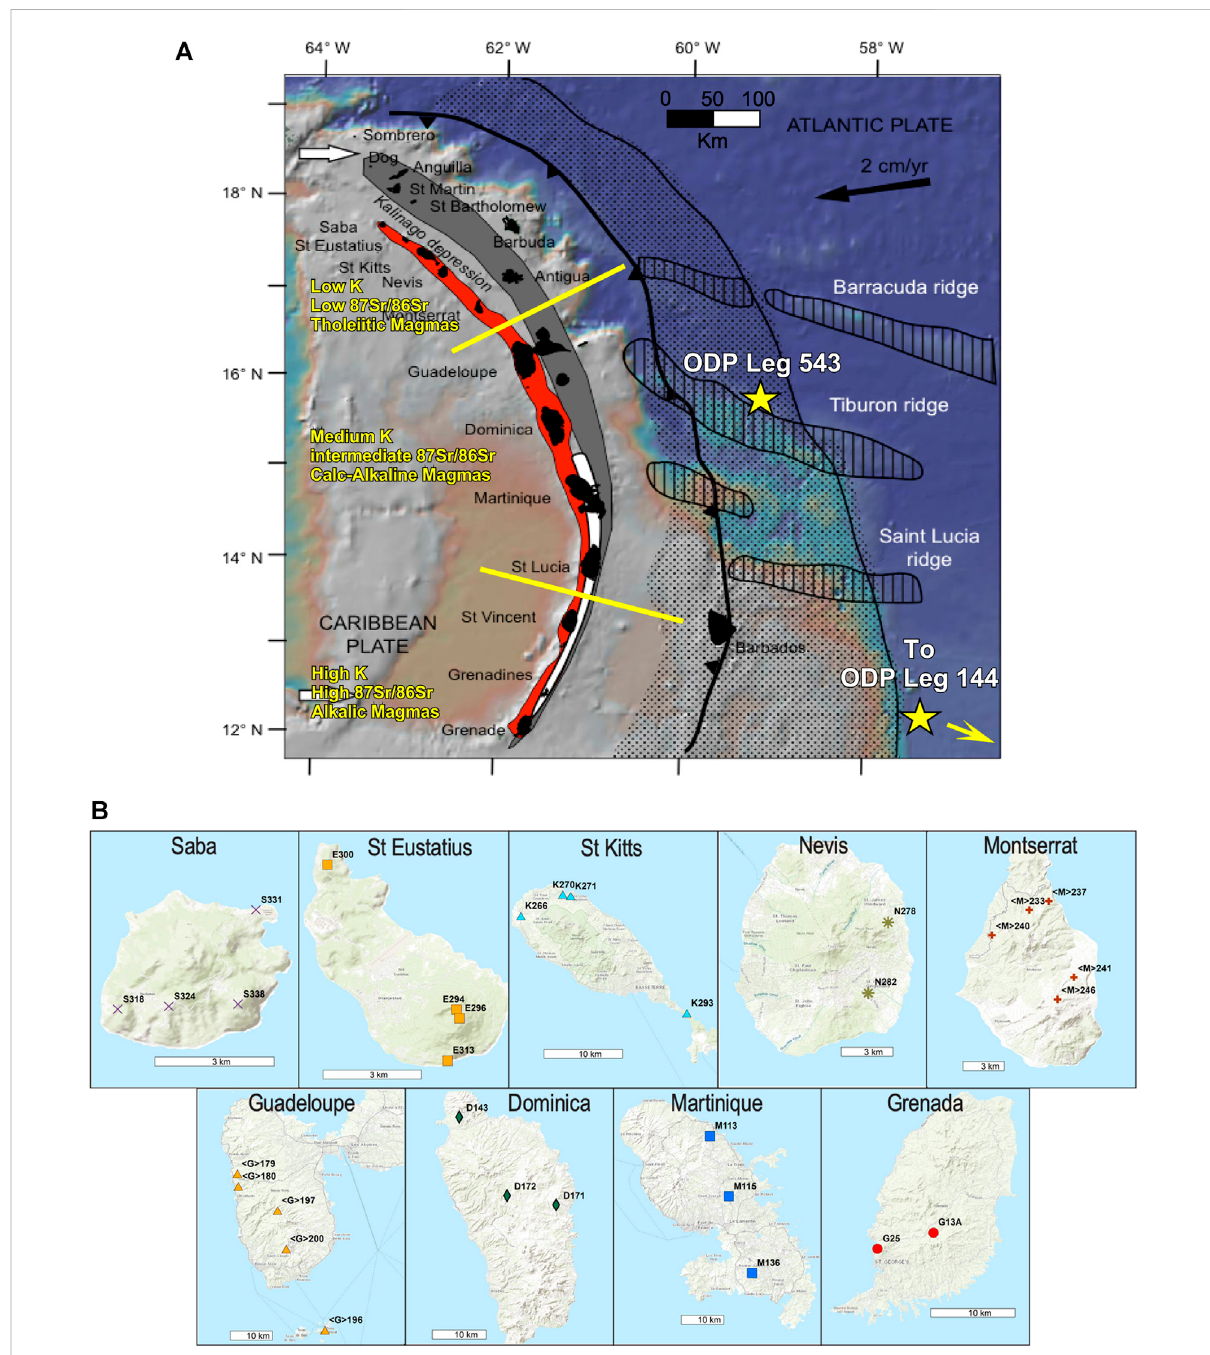
FIGURE 1 (A) MapoftheLesserAntillesVolcanicarcshowingtherecentarc(0 – 7 Ma;red),intermediatearc(7 – 15 Ma;white)andtheolderarc(15 – 25 Ma; gray)inferredextent.Inthenorthathinlayerofoceanicsedimentsisexpectedtosubductwhereasinthesouthwecanseeathicklayerofcontinental sediments(Barbadosaccretionaryprism,dottedarea)duetoIn fl uxfromAmazon±OrinocoRiver.AlsoshownaretheaseismicSt.Lucia,Tiburonand Barracuda Ridges as well as the location of DSDP Leg 78A Site 543 (yellow star). DSDP Leg 14 Site 144 is on the Demarara Rise located on the northern edge of South America between the Amazon and Orinoco deltas. Also noted are the chemical classi fi cations of magmas for north, central and southern LAIA as denoted by White and Dupree (1986). Figure modi fi ed from Germa et al., 2011, DuFrane et al., 2009 and Davidson 1987. (B) Detailed map of sampling locations for rocks collected by F. Nagle and J. Stipp during their 1969 fi eld campaign. Precise locations are based on a highly detailed hand drawn map and associated fi eld notes created by Nagle. Some sampling locations are listed in Nagle et al.